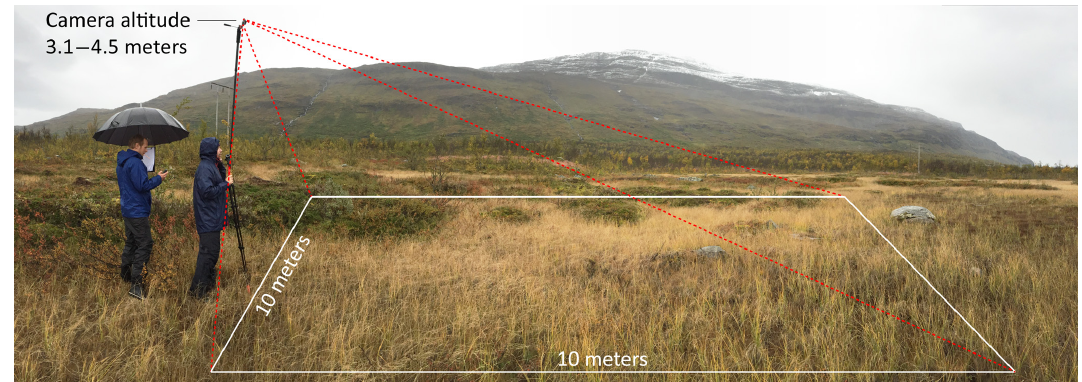
Figure 1. A remotely controlled wide-field camera mounted on a long monopod captures the scene in one shot, from above the horizon down to nadir. After using the horizon image position to correct for the camera angle, a 10 × 10m area close to the camera is used for classification.